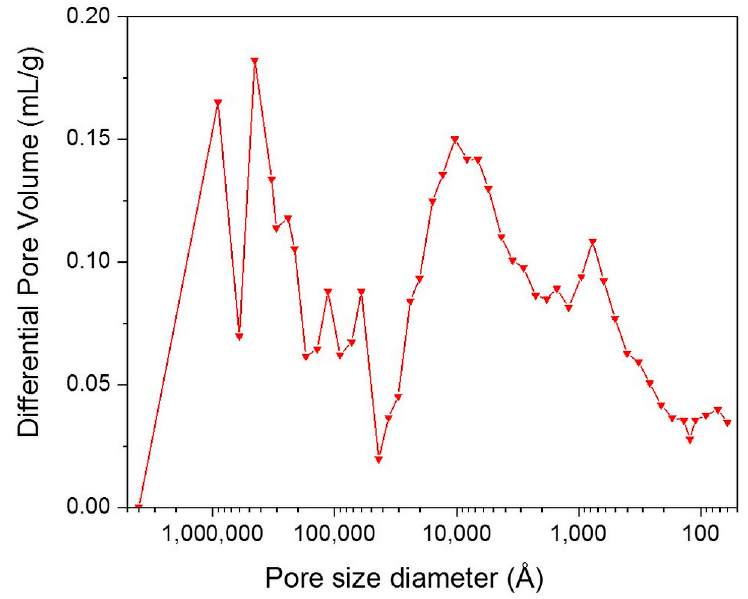
Figure 4. Pore distribution by Hg intrusion of the alkali-activated monolith.